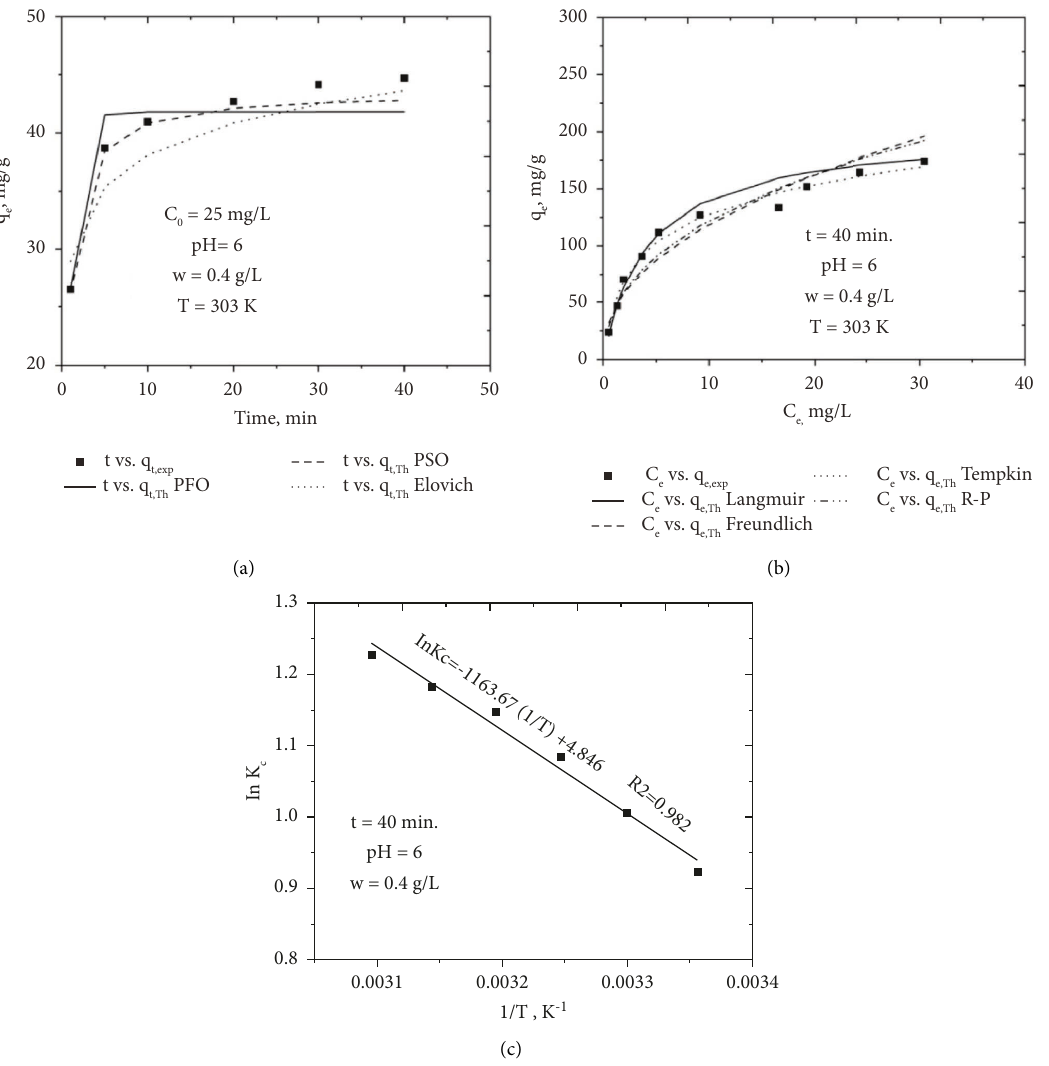
Figure 9: (a) Kinetic studies. (b) Equilibrium studies. (c) Thermodynamic studies for adsorption of MB by